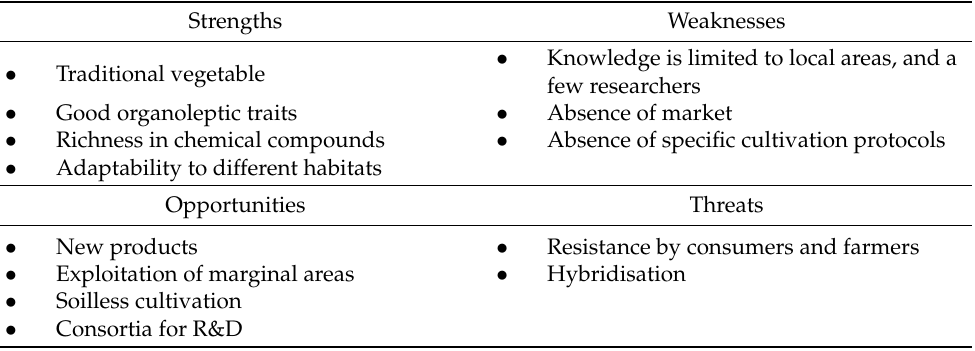
Table 4. SWOT analysis related to the exploitation of H. sphondylium as a new cash crop. Strengths